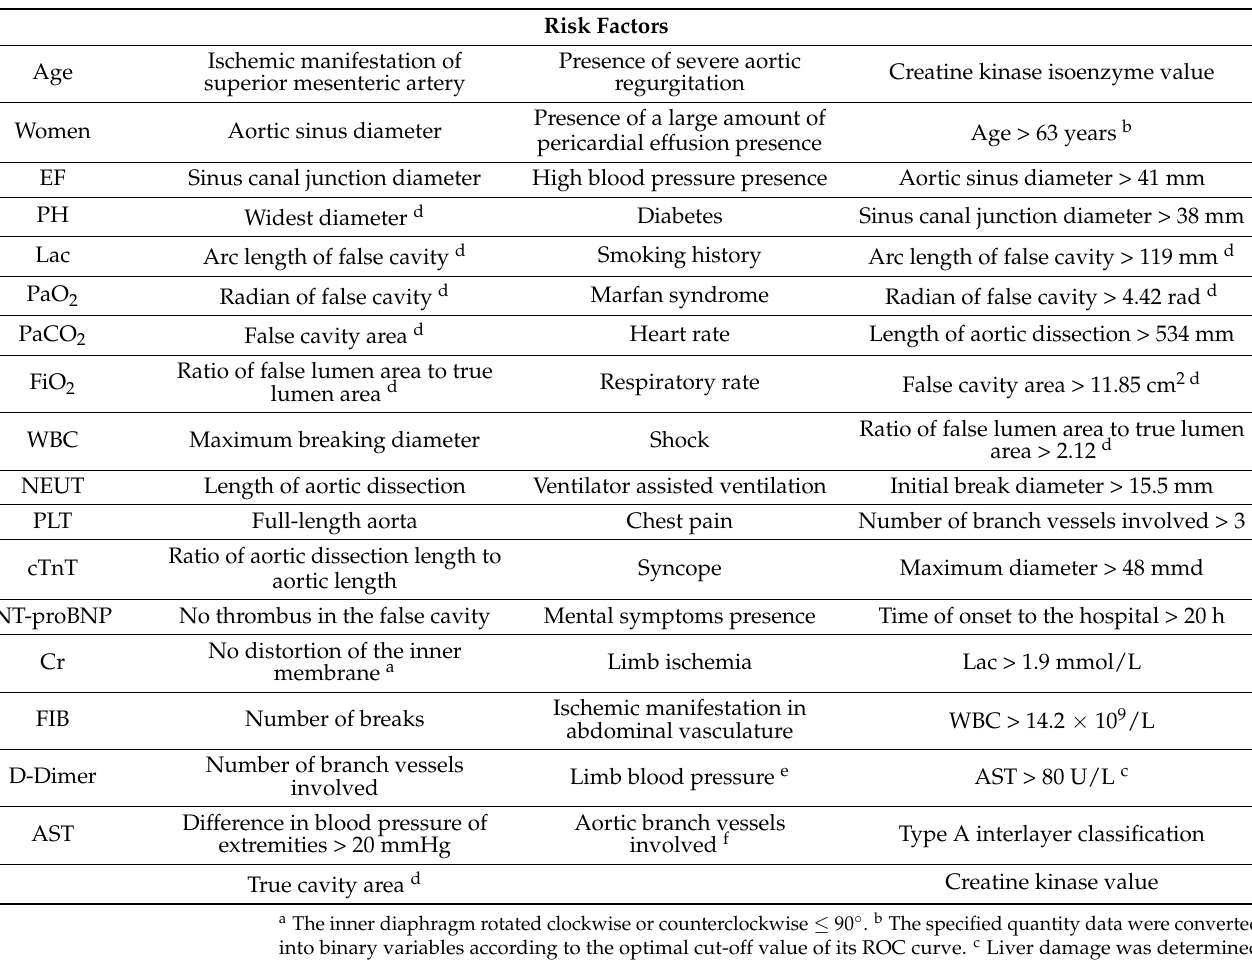
Table 1. Risk factors for acute type A aortic dissection.